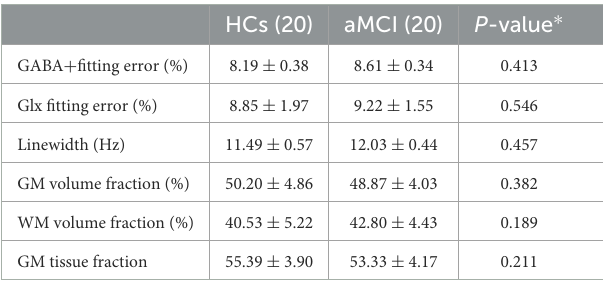
TABLE 2 MRS quantification and voxel segmentation results.